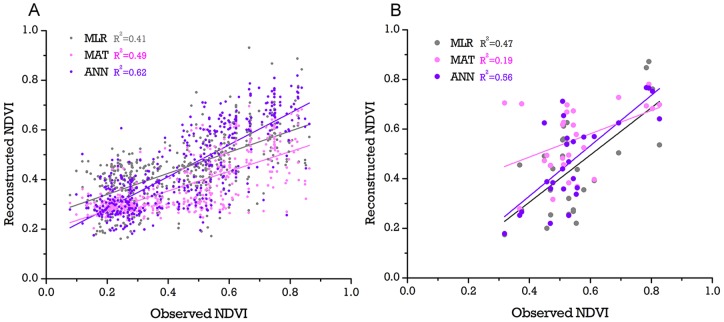
Result of model reconstruction and verification.In subplot A, LR, MAT and ANN all performed well in the model construction phase and passed the 0.01 significance level test; in subplot B, when verified by lake surface sediment pollen data, MAT failed to produce a reliable result. ANN was chosen for the reconstruction. All R2 data are the adjusted R square.